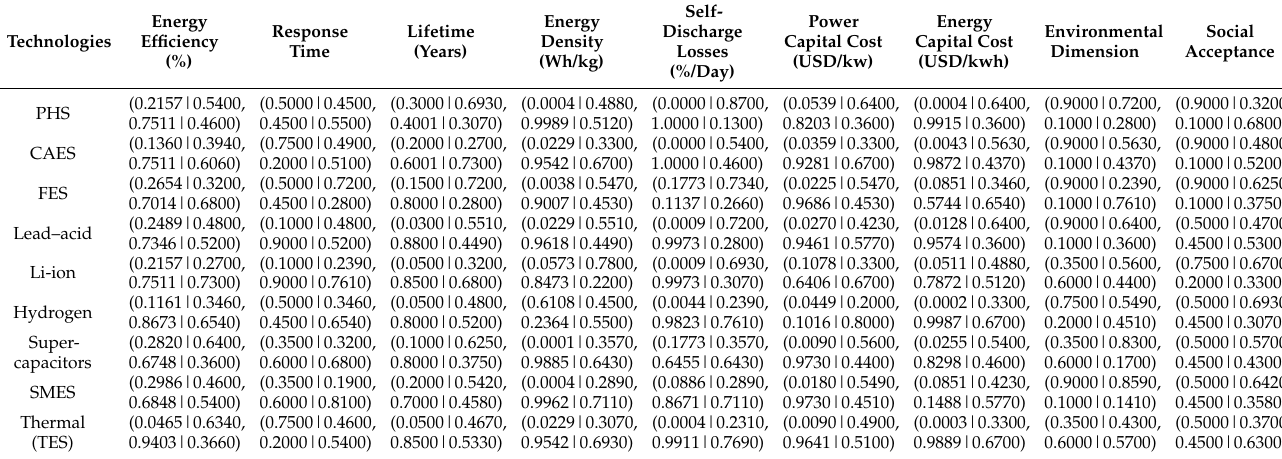
Table A18. Initial decision matrix of Expert 10.